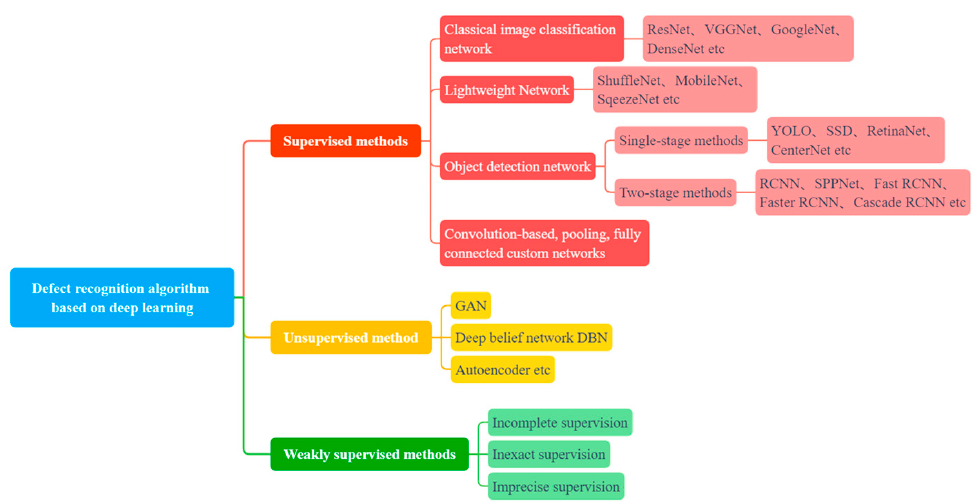
Figure 5. Defect recognition algorithm based on deep learning.